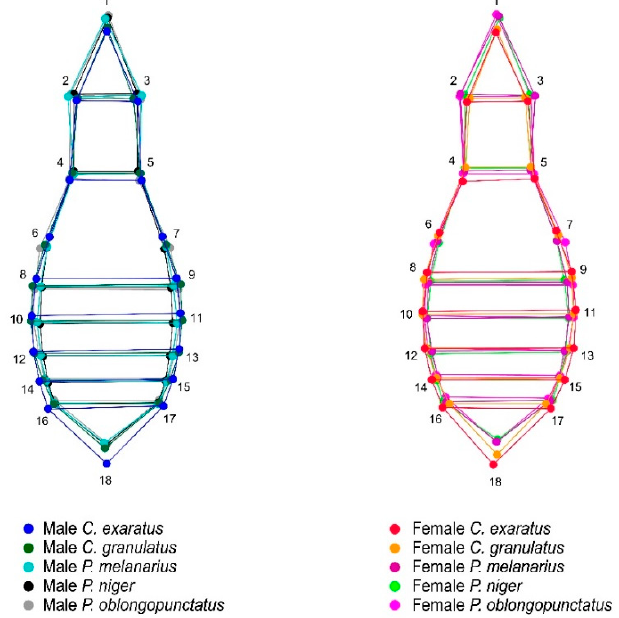
Figure 4. Wireframe representation of the average ventral shape variations and their corresponding landmarks between males and females of all the corresponding species analyzed in this study: Carabus exaratus , Carabus granulatus , Pterostichus melanarius , Pterostichus niger , and Pterostichus oblongopunctatus . * The wireframe was aligned using starting shape.